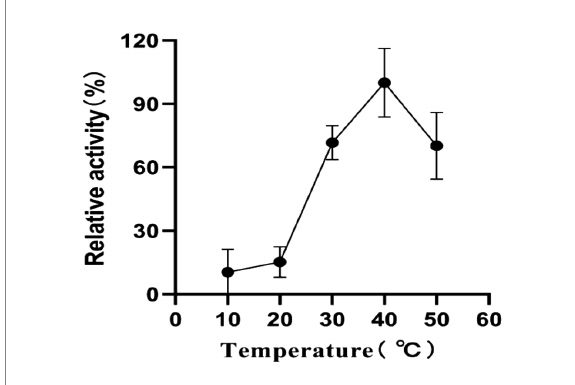
FIGURE 5 The effect of temperature on the activity of RpfB recombinant protease.